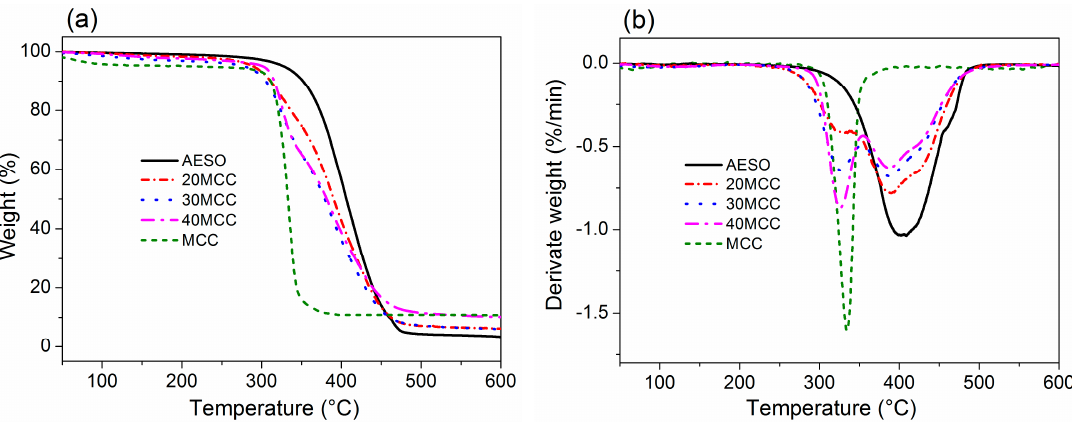
Figure 6. TG and DTG curves of pure MCC, AESO, and MCC/AESO composites with different MCC loadings.